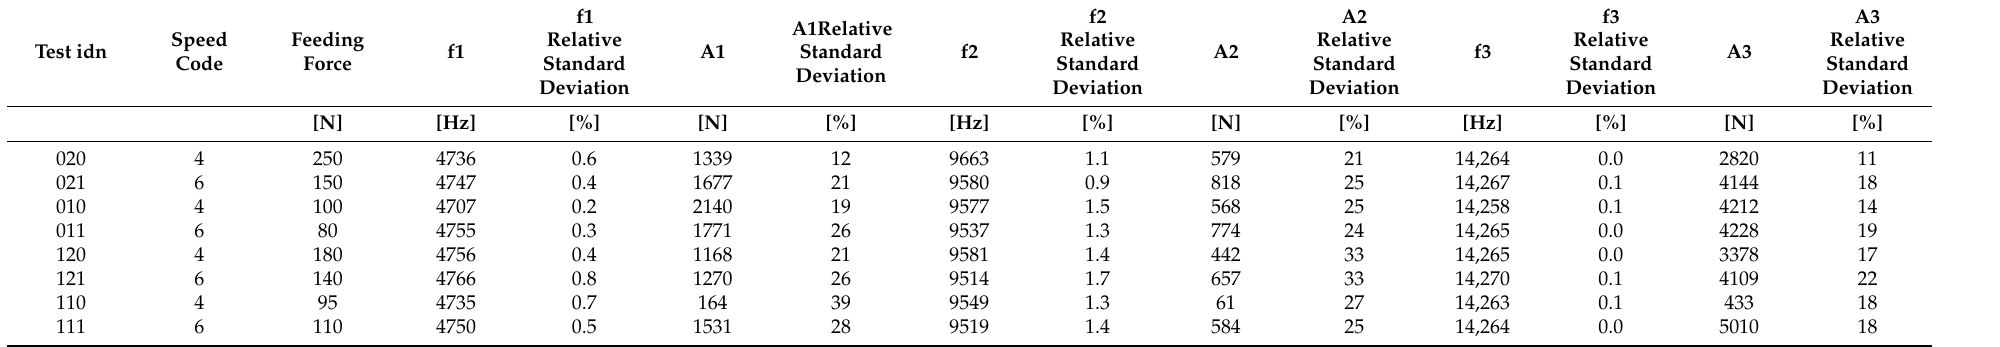
Table 6. Measured frequencies and amplitude for the